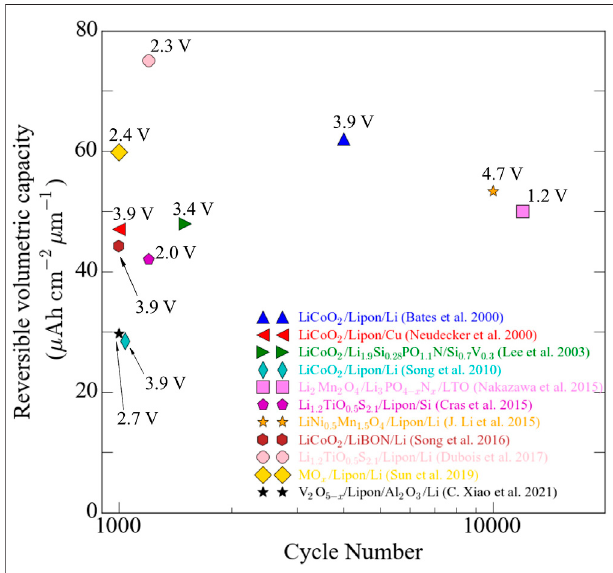
FIGURE 6 | Reversible volumetric capacity of selected ASTBs with approximate nominal